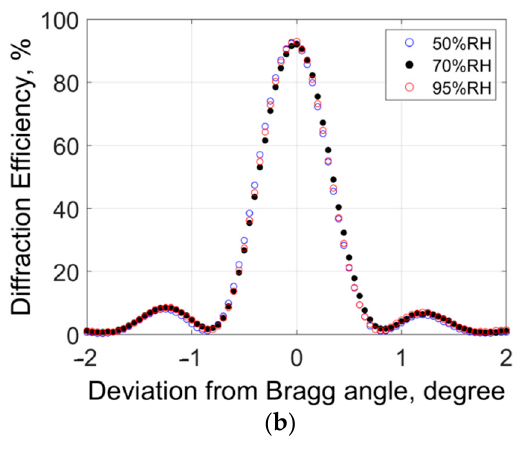
( b ) Figure 5. ( a ) Normalised diffraction efficiency (DE) versus the exposure (recording) time shows the effect of UV-curing on the grating fixation. Normalised diffraction efficiency was calculated as the ratio of the diffraction efficiency obtained after UV-curing and after recording; ( b ) Bragg selectivity curves of the transmission grating recorded using 30 s exposure demonstrate stability of the diffrac- tion efficiency after UV-curing. 3.5. Environmental Stability In the current research, the impact of the environmental humidity and temperature on grating stability was investigated by monitoring the diffraction efficiency of transmis- sion gratings at relative humidity up to 95% and temperature of 130 °C, respectively. For the humidity test, the sample was placed in a controlled environment chamber (Electro- tech system, Perkasie, PA, USA, model LV 202-E) as shown in Figure 6a. Diffraction effi- ciency was measured before humidity exposure at ambient humidity of 50% and temper- ature of 21 °C (Figure 6b). Then, the humidity level was increased to 70% and the temper- ature was kept constant at 21 ± 0.3 °C. After 60 min, the sample was removed from the